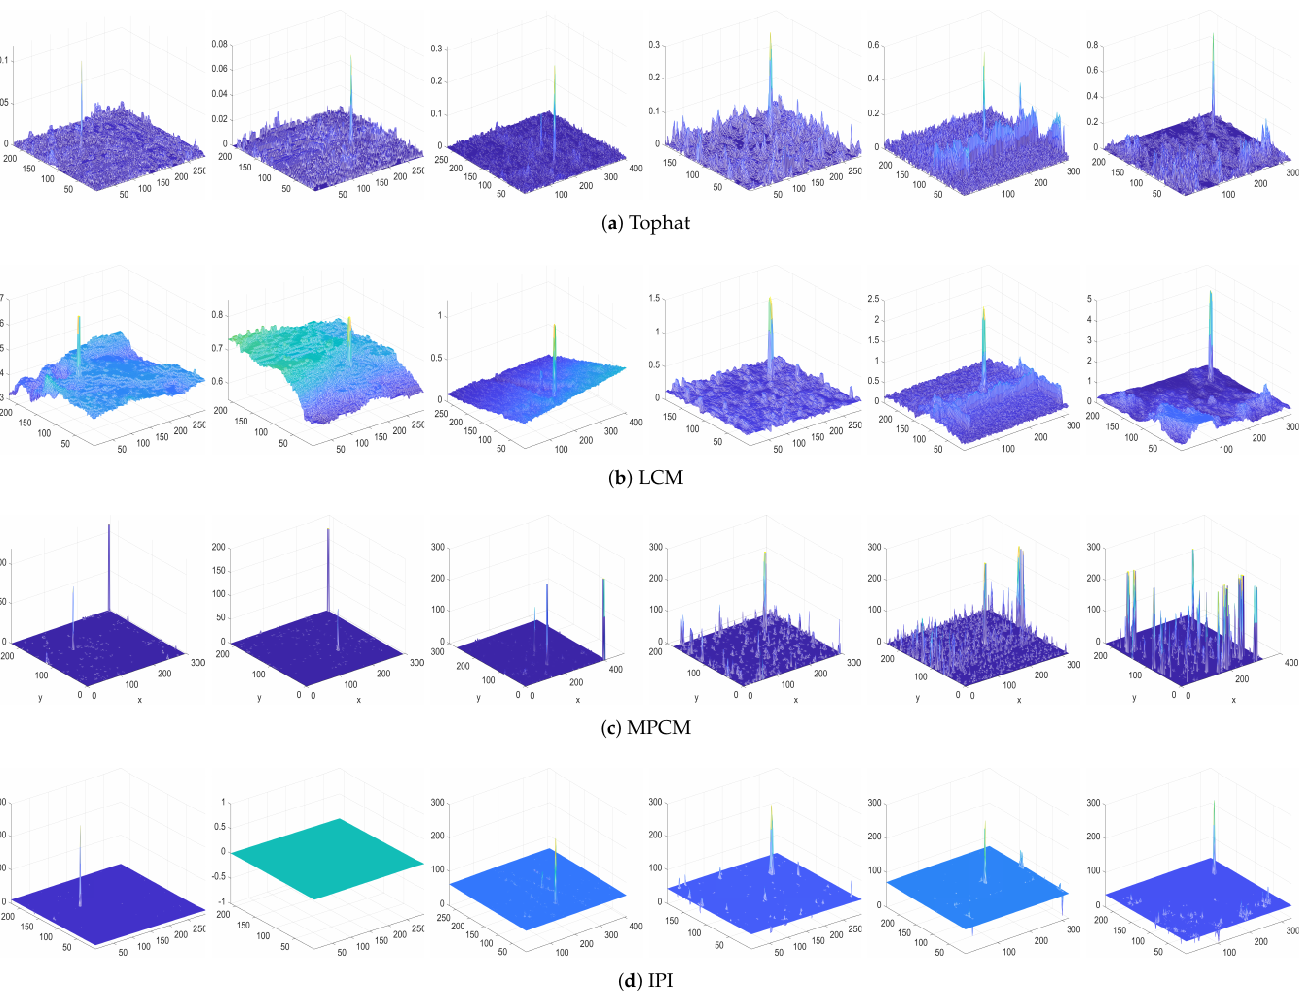
Figure 9. From left to right are the detection results of 1 ∼ 6 sequence images (Continued).